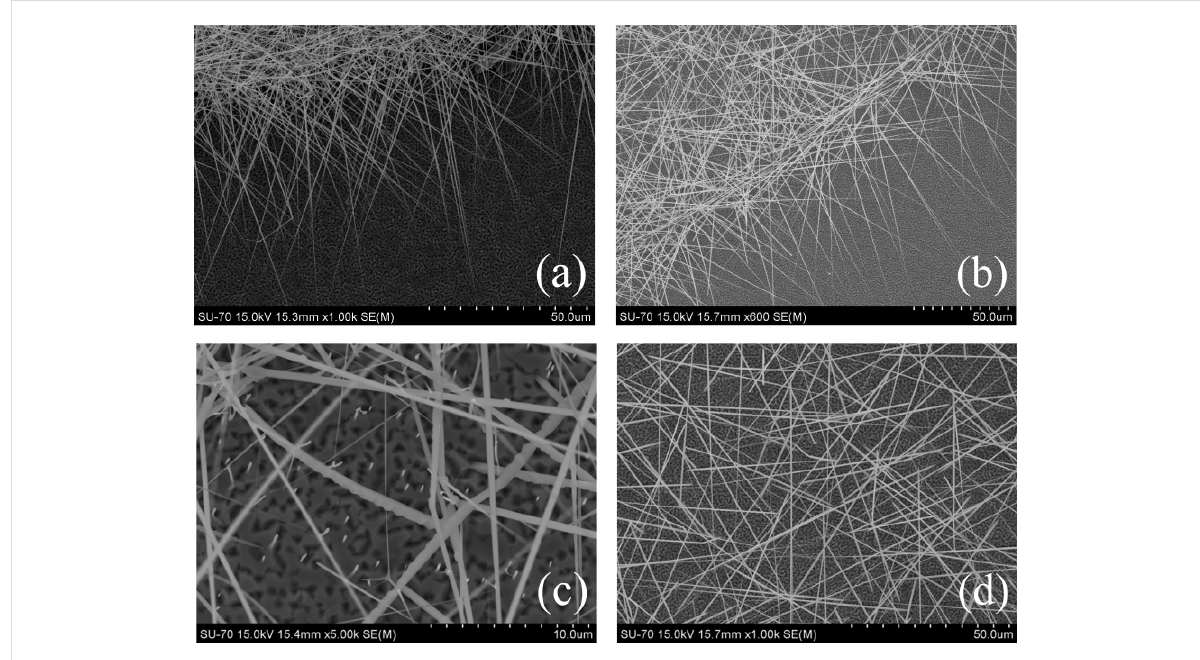
Figure 2: Scanning electron images of GaAs nanowires grown on GaAs(111)B (a,c) and on Si(111) (b,d) substrates. Images (a) and (b) show the border regions of bunches of nanowires, whereas (c) and (d) show the inner regions.